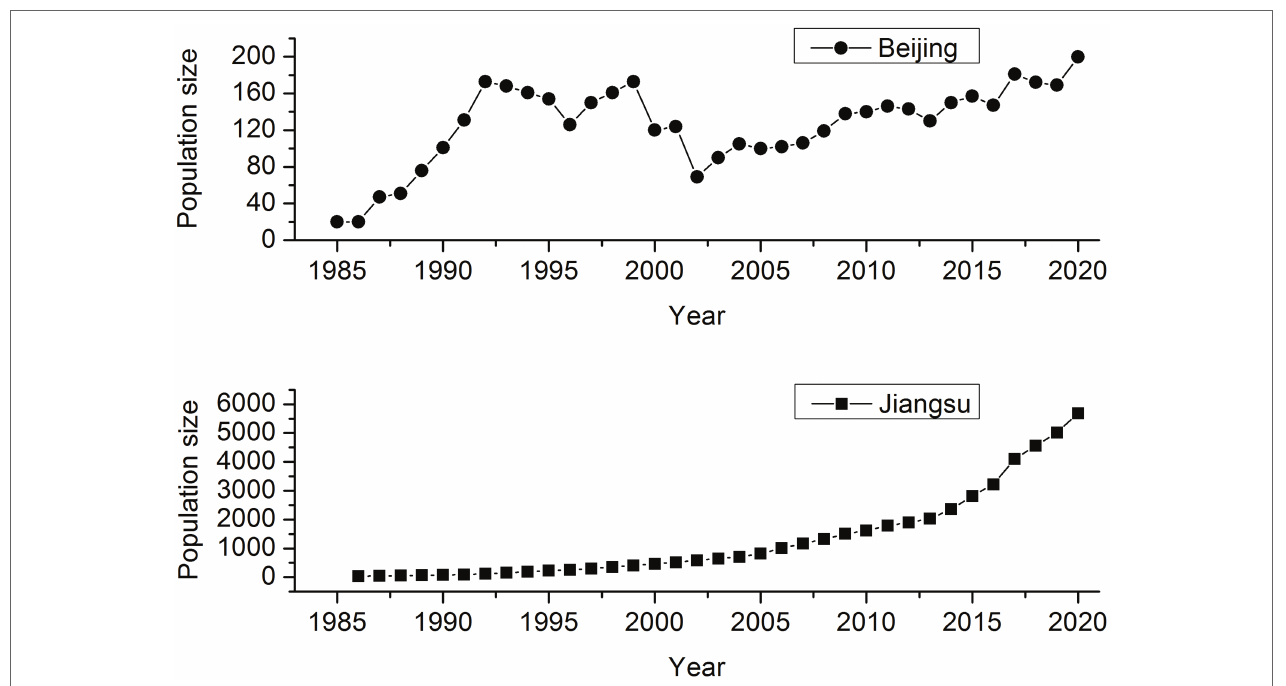
FIGURE 1 | Population size trend of Père David’s deer in Beijing Père David’s deer Park and Jiangsu Dafeng National Nature Reserve (including both the free- ranging and wild